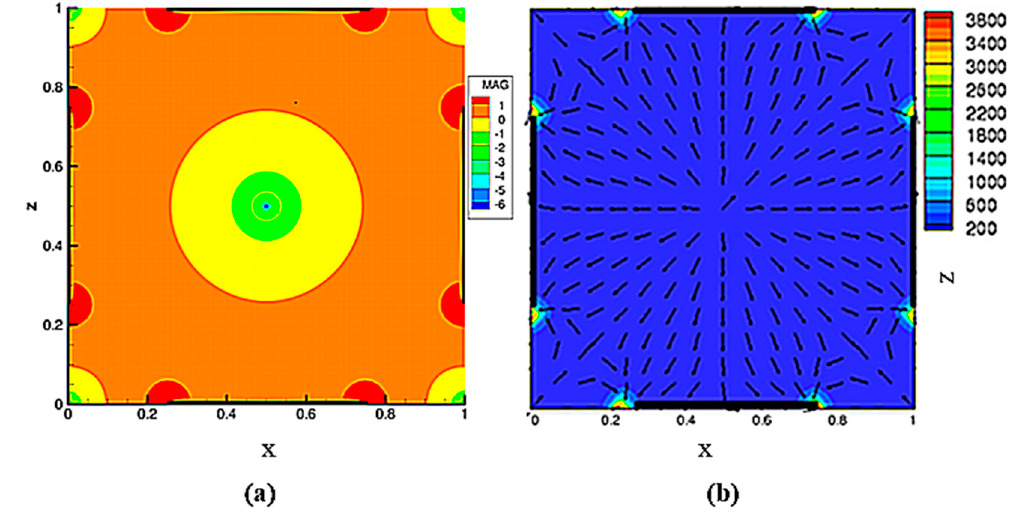
Figure 5. Electric field (log| E |) and ∇ E 2 distributions in a DEP cage. The dimensionless parameters are: Re = 0.113, P E = 3080, and P 4 = 0.668. ( a ) Isovalues of log| E | at y = 0.25, i.e., the domain mid-plane. Electric field does not vary in the y-direction. The magnitude of | E | is maximal near the electrode edges and decreases with increasing distance from the electrodes. The minimum of | E | is at the center. ( b ) The magnitude and direction of ∇ E 2 to which the DEP force is proportional. Arrows indicate the direction of positive DEP force (for negative DEP, the direction is the opposite) and the isovalues levels give the magnitude.